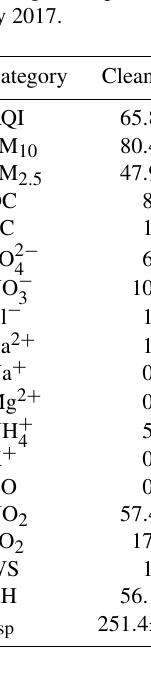
Table 1. The concentrations of particulate matter and its chemical components (µgm − 3 ), light scattering coefficients (Mm − 1 ), and selected meteorological parameters including wind speed (WS; ms − 1 ) and relative humidity (RH; %) at all the three sites for different pollution